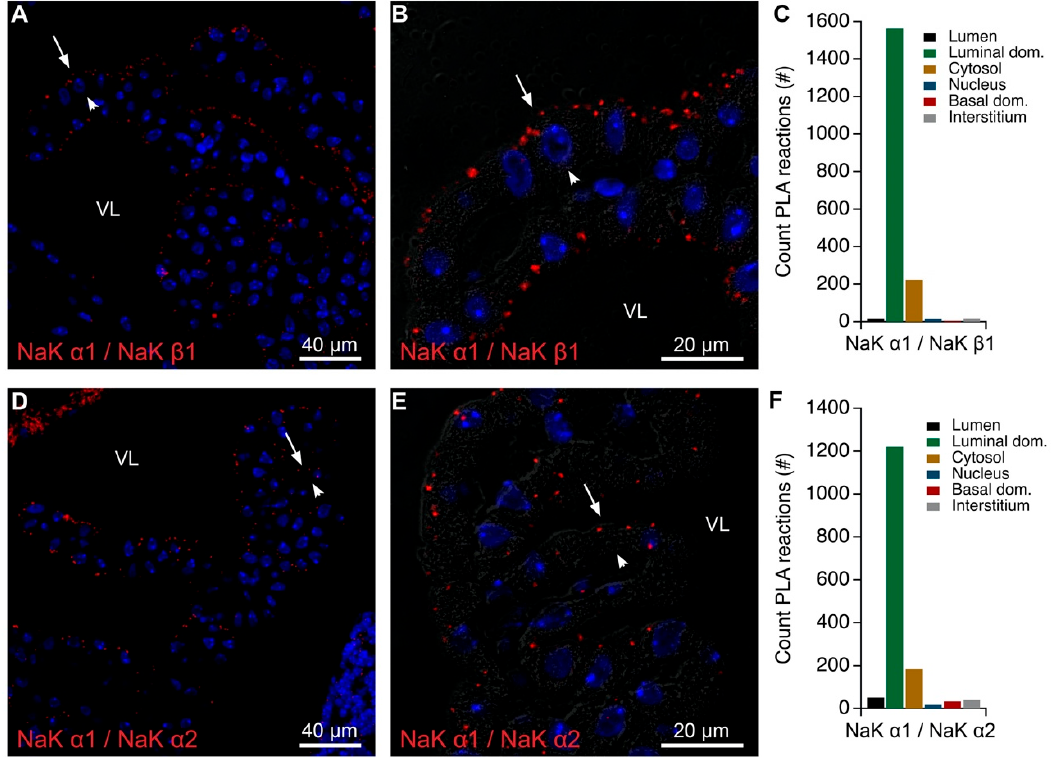
Figure 2. Colocalization of Na,K-ATPase subunits by proximity ligation assay (PLA). ( A ) Representative immunofluores- cence image of PLA products (red) using anti-Na,K-ATPase α 1 (NaK α 1) and anti-Na,K-ATPase β 1 (NaK β 1) antibodies and cell nucleus counterstain (blue) at low magnification. ( B ) Higher magnification micrograph of the same structure overlaid on the corresponding DIC image. ( C ) Bar graph representing the count of PLA reactions in the indicated image areas. ( D ) Representative immunofluorescence image of PLA products (red) using anti-Na,K-ATPase α 1 (NaK α 1) and anti-Na,K-ATPase α 2 (NaK α 2) antibodies and cell nucleus counterstain (blue) at low magnification. ( E ) Higher magnifi- cation micrograph of the same structure overlaid on the corresponding DIC image. ( F ) Bar graph representing the count of PLA reactions in the indicated image areas. Arrows indicate luminal surfaces, while arrowheads mark basolateral sur- faces. VL denotes the fourth ventricle lumen.